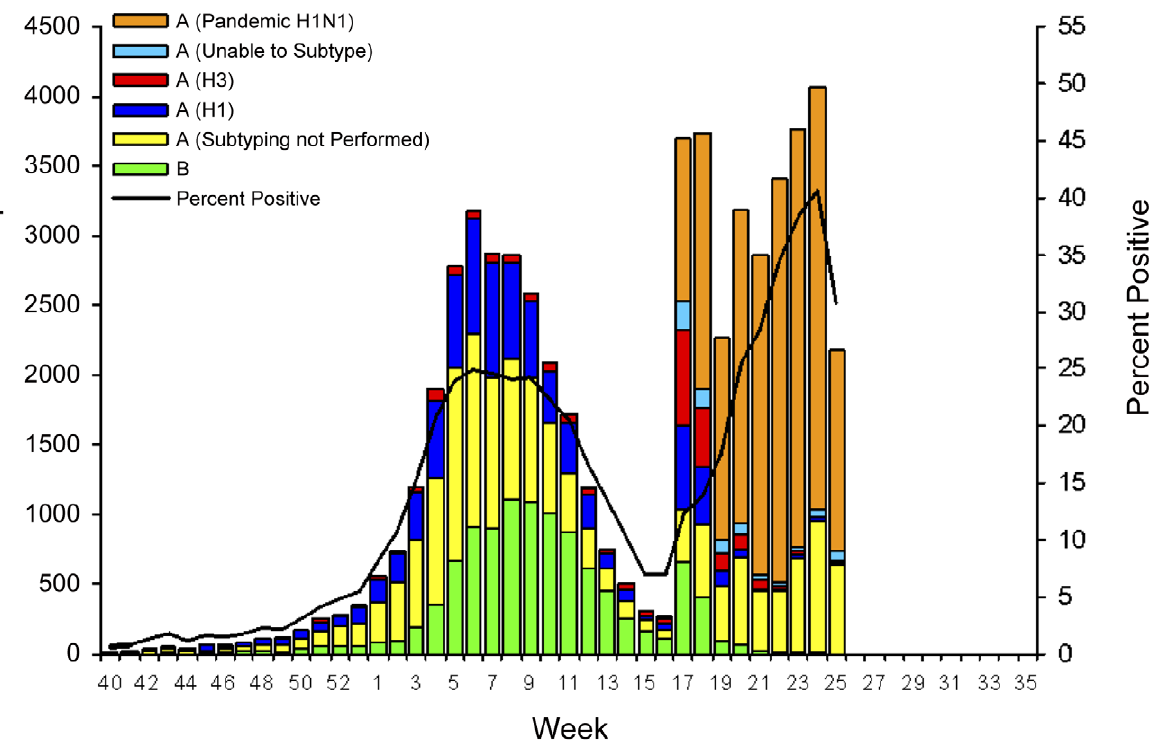
Figure 5. Laboratory-confirmed influenza cases reported to CDC by U.S. WHO/NREVSS collaborating laboratories, national summary, 2008– 09. Source: CDC Flu View, 2008–2009 Influenza Season Week 25 ending June 27, 2009. Available from: http://www.cdc.gov/flu/weekly/ weeklyarchives2008-2009/weekly25.htm.